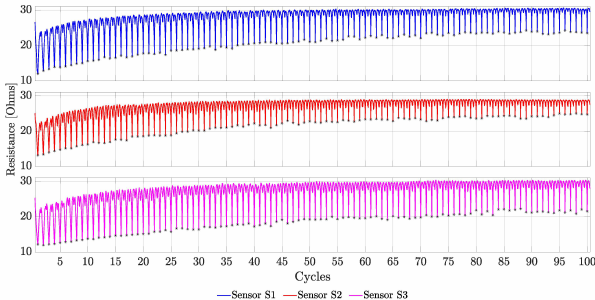
Figure 15. Sensor drift over the course of 100 stretching cycles. For each of the three sensor samples, the drift stabilizes around the 40th cycle. The black stars on each plot indicate the maximum strain applied (66%), which was measured halfway through the stretching